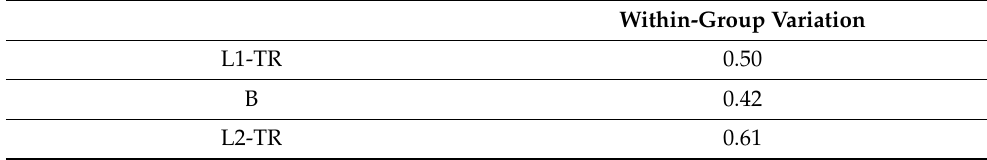
Table 11. F0 variation within Turkish speaker groups (i.e., deviation from the own group means).